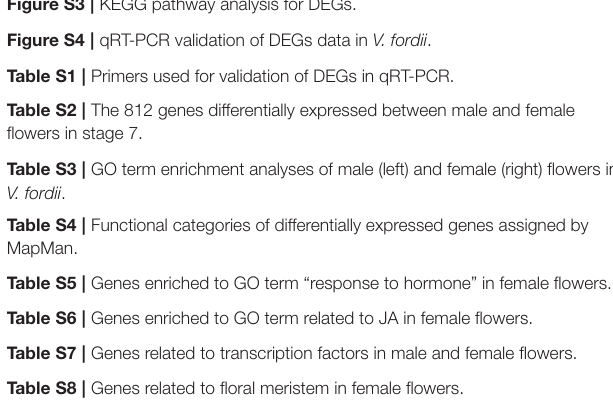
Figure S1 | The distribution and proportion of all assembled contig lengths. Figure S2 | Gene ontology (GO) classification for all assembled unigenes using SuperViewer tool with normalized results. Figure S3 | KEGG pathway analysis for DEGs. Figure S4 | qRT-PCR validation of DEGs data in V. fordii . Table S1 | Primers used for validation of DEGs in qRT-PCR. Table S2 | The 812 genes differentially expressed between male and female flowers in stage 7. Table S3 | GO term enrichment analyses of male (left) and female (right) flowers in V. fordii . Table S4 | Functional categories of differentially expressed genes assigned by MapMan. Table S5 | Genes enriched to GO term “response to hormone” in female flowers. Table S6 | Genes enriched to GO term related to JA in female flowers. Table S7 | Genes related to transcription factors in male and female flowers. Table S8 | Genes related to floral meristem in female